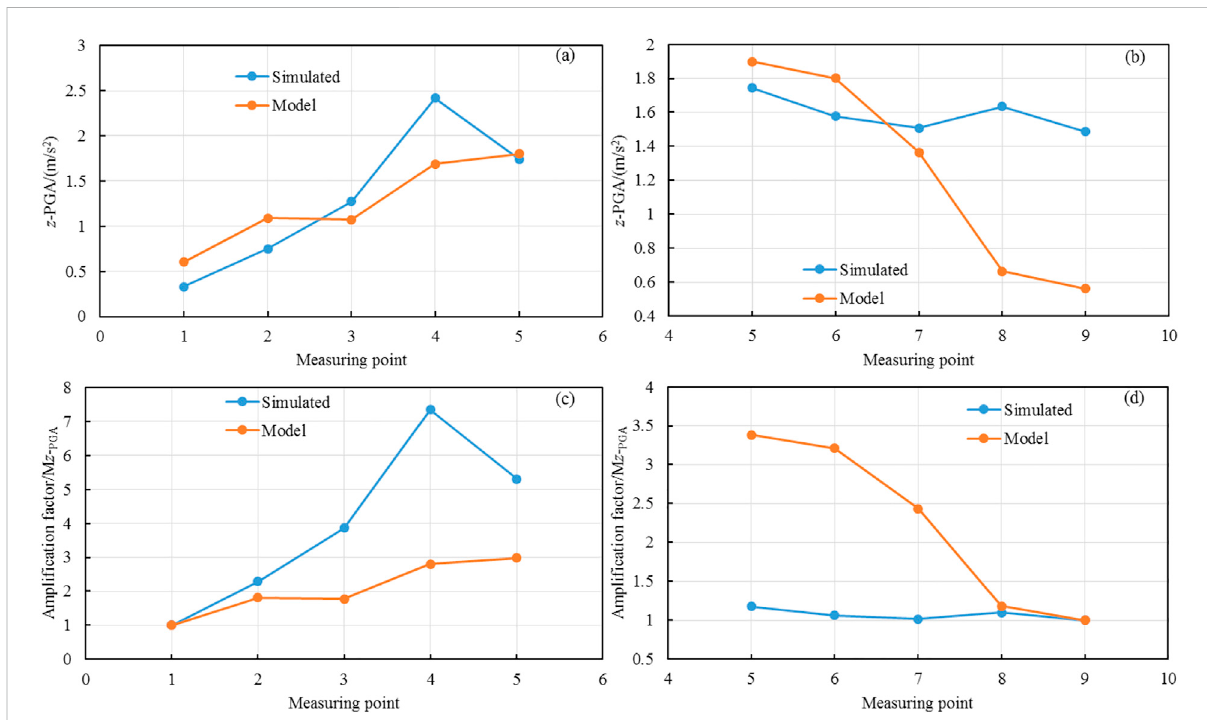
FIGURE 14 Vertical PGA and ampli fi cation factors of each measurement point of the slope. (a) z-PGA of the loess-slope surface; (b) z-PGA of vertical section; (c) Ampli fi cation factor of z-PGA of the loess-slope surface; (d) Ampli fi cation factor of z-PGA of vertical section.